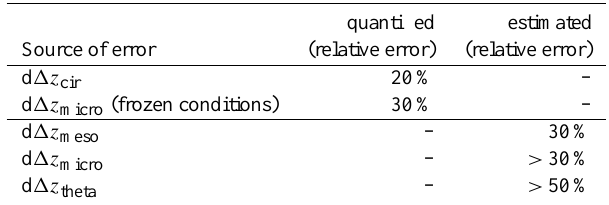
Table 4. Estimates of effective ice crystal radius ( r) derived from Eq. (1) for the values of 1z and τ of the cirrus quasy-stationary periods considered in the Match approach. Calculations are made for five different ice crystal number concentrations ( N 0 ) .